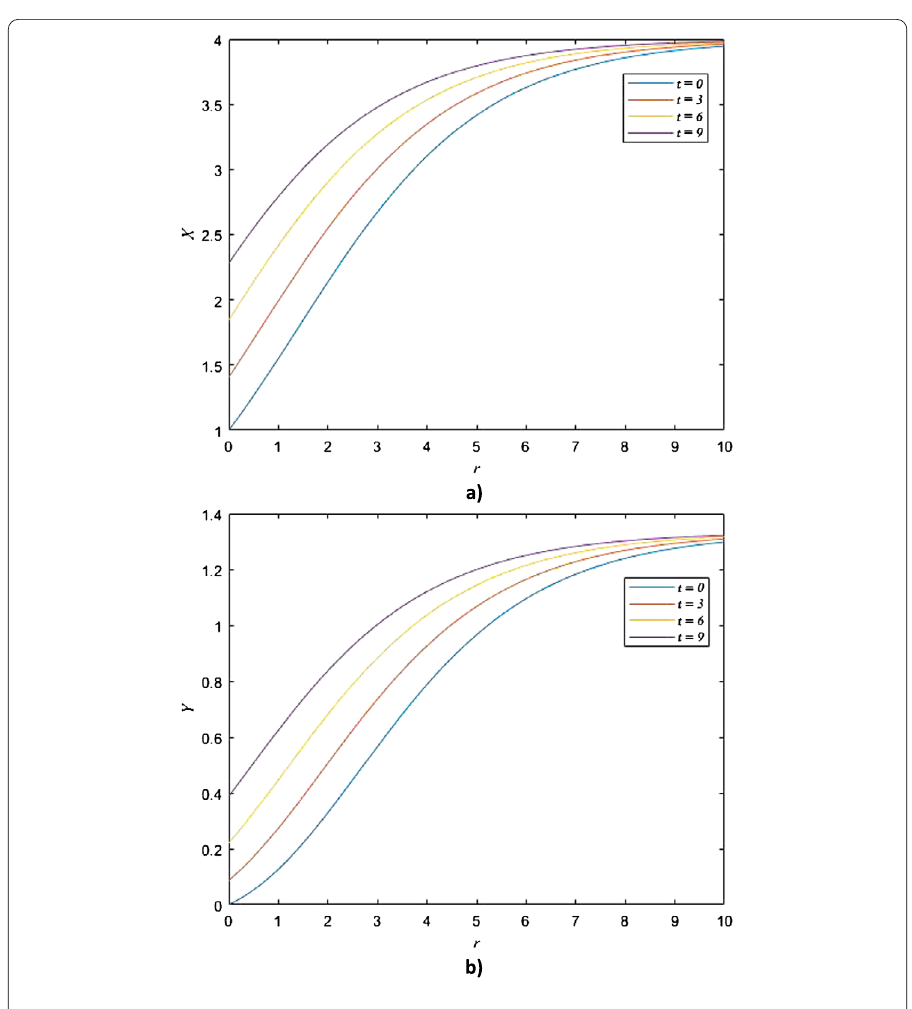
Figure 2 Traveling wave solution. Traveling waves of ( a ) fish density x , and ( b ) recruitment intensity y , as functions of spatial position r for t from 0 (furthest left) to 9 (furthest right), given by (31)–(32). The waves are seen moving from right to left. Here, a = 1, b = 1